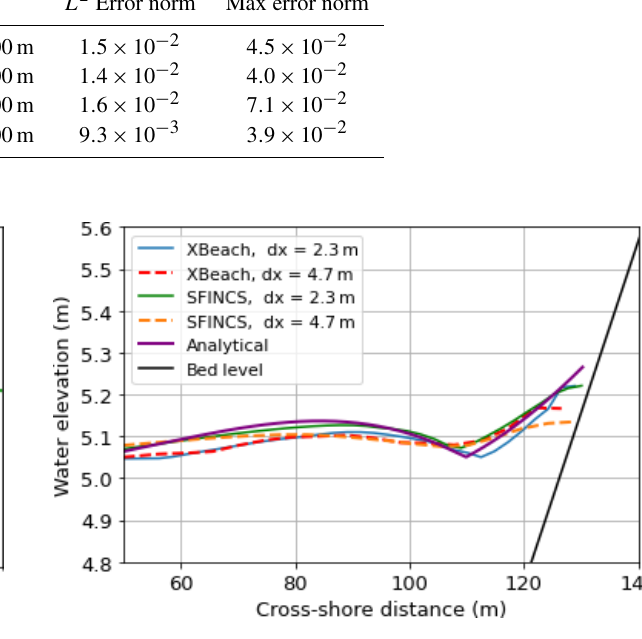
Figure 13. Comparing the maximum elevation height achieved at every point in the domain over the entire simulation when using SFINCS and XBeach at d x = 2 . 3m and d x = 4 . 7m (corresponding to 64 and 32 mesh cells in the x direction respectively) with the an- alytical result for the Carrier–Greenspan test case. A slope of 0.041 is used in all simulations. Note that the water elevation height does not always meet the bed level because the bed level is slightly dif- ferently defined at the different